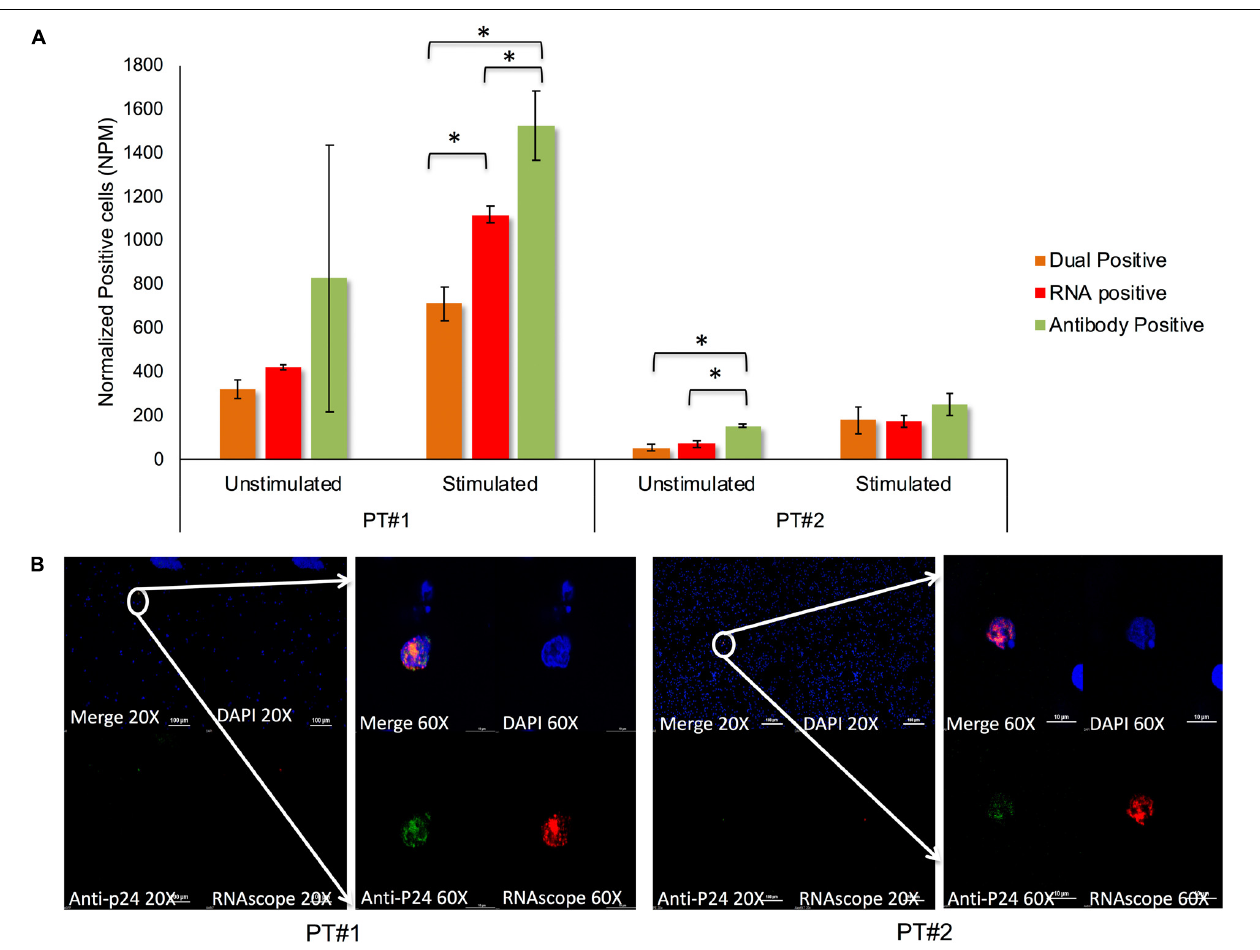
FIGURE 6 | Counting of translation-competent cells in patients derived PBMC by RNAscope. (A) Ex vivo detection of HIV-1 mRNA and p24 protein in clinical samples using PBMCs from two therapy-naïve individuals with and without cLRA activation. After cLRAs stimulation, detectable HIV mRNA + / p24 + cells increased to 710 and 184 in Patient#1, Patient#2 indicating a reactivation of latent virus within the clinical samples. Patient 1 was infected with CRF01_AE viruses and had plasma viremia 1970000 copies/mL while patient 2 was infected with HIV-1C viruses with plasma viremia 69700 copies/mL. p < 0.05 are marked with ‘ ∗ ’ and consider significant. (B) Wide-field analysis, all HIV mRNA + / p24 + positive cells could be detected as single cells exhibiting viral mRNA correlating with anti-p24 detection indicating the applicability of the method at single-cell